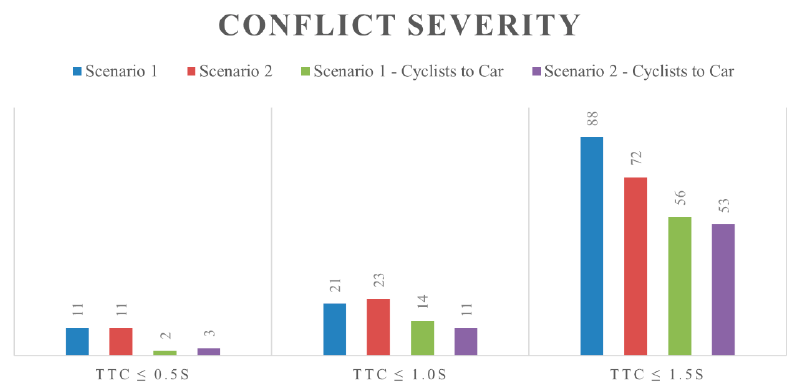
Figure 12. Number of conflicts by severity.